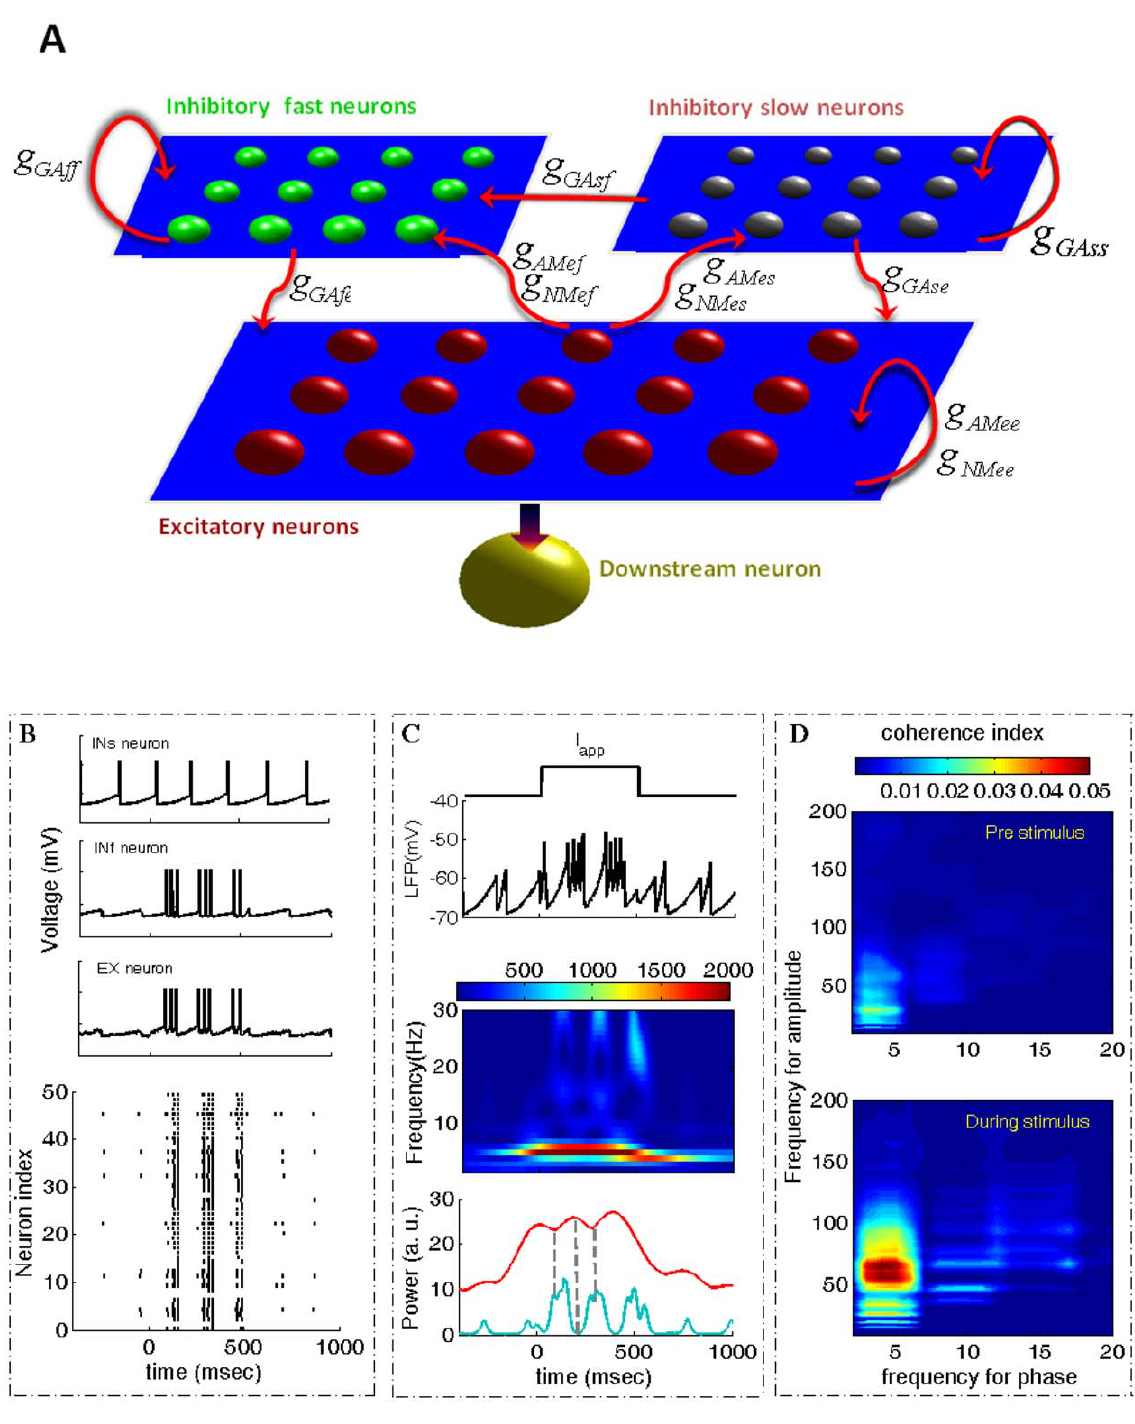
Figure 1. Stimulus-enhanced theta wave as well as CFC. (A) A network of 100 excitatory (EX), 50 fast inhibitory (INf) and 50 slow inhibitory neurons (INs). The outputs of EX neurons are projected to a downstream neuron. (B) The firing behaviors of single INs, INf and EX neurons. The bottom trace is the firing pattern of 50 EX neurons. (C) Input stimulus (Iapp), the LFP which is the average of membrane potentials of all EX neurons, the time-dependent power spectrum of the LFP of mean powers in the theta (red curve) and in the gamma band (blue curve). (D) Coherence of CFC between the theta phase and the gamma amplitude for the pre and during stimulus epochs. doi:10.1371/journal.pone.0036472.g001 To explore more fully the effects of these two inhibitory synaptic strengths. Effects of increasing the reciprocal connection strength couplings on the behavior of the network we plotted theta and were also plotted by increasing the strength of AMPA receptor gamma amplitudes, the coherence of CFC and theta phase ( g AMes and g AMef ). In Figures 2B and C, respectively it can be seen variation as a function of increases in either g GAse or g GAfe that across a range of g AMes values, as g GAse is strengthened then